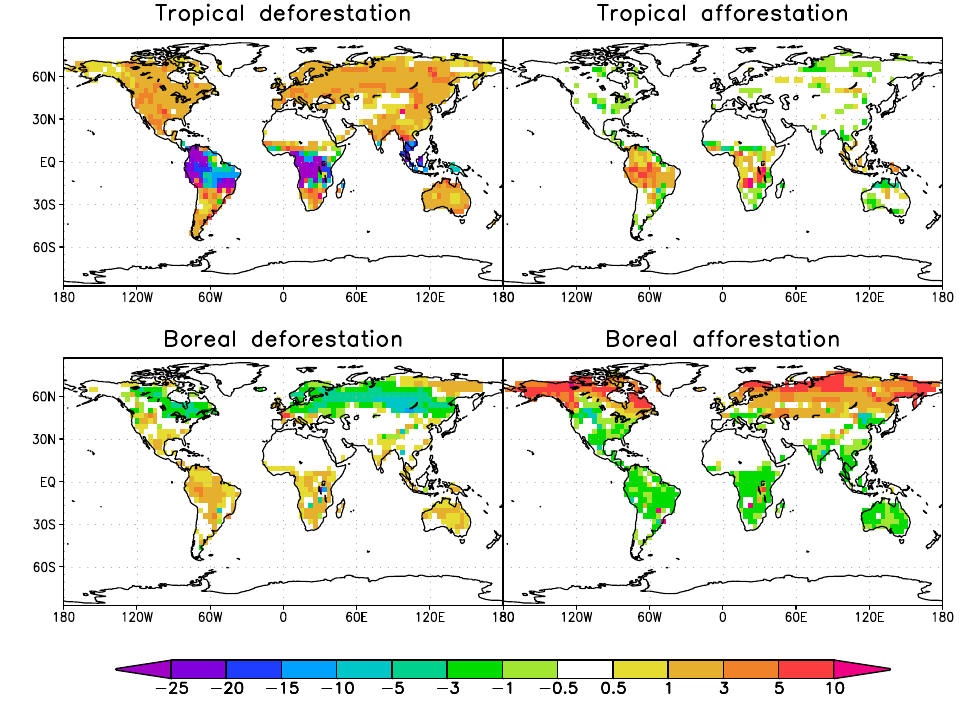
Fig. 6. Total land carbon anomalies in kg/m 2 for each experiment, averaged over the final 10years. Table 1. Terrestrial carbon storage anomalies in kg/m 2 , averaged over the manipulated land cells and the final 10years of each experiment (ice sheets not included).